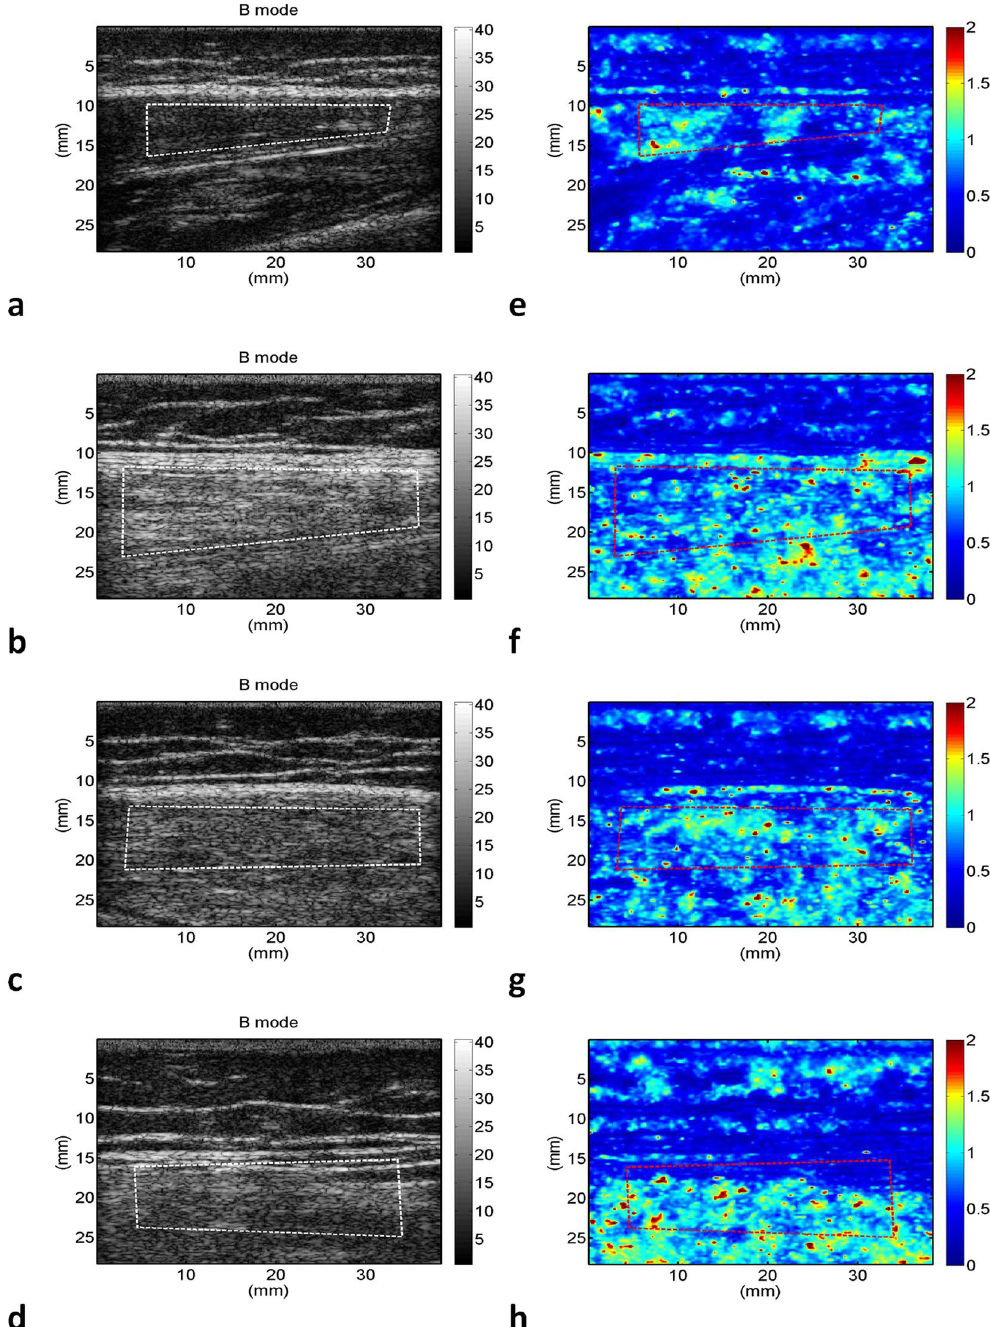
Figure 1. Grayscale B-mode images of the rectus femoris muscle of the ( a ) controls; ( b ) stage 1 DMD patients; ( c ) stage 2 DMD patients; and ( d ) stage 3 DMD patients. ( e – h ) Corresponding WMC Nakagami images showing an increase in the brightness of the WMC Nakagami image with an increase in the DMD